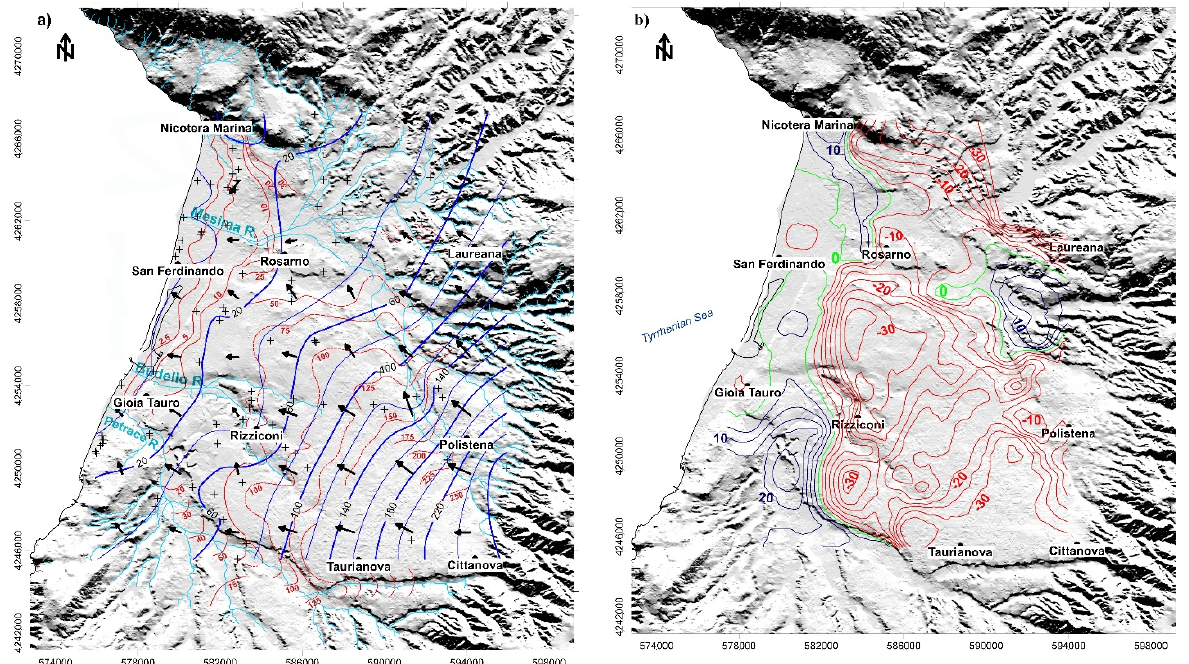
Figure 6. ( a ) Piezometric map of the Gioia Tauro plain. In the figure are reported locations of each well, the current piezometric contour lines (blue) and flow directions (black arrows), and the 1970s piezometric lines (red) [36]. ( b ) Piezometric level variation map from the 1970s to 2021 (red line: level drop; green line: unchanged level; blue line: level rise).